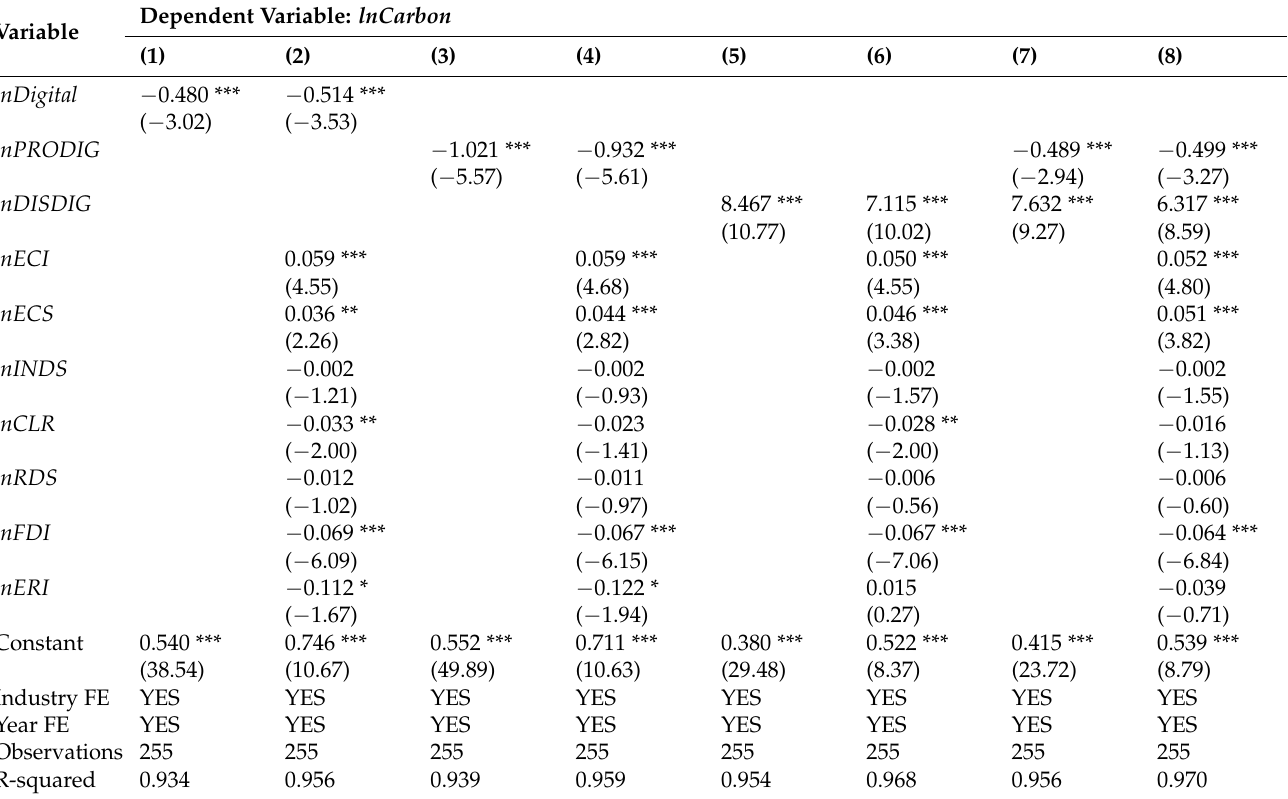
Table 5. Benchmark regression results of model (1), with core explanatory variables and control